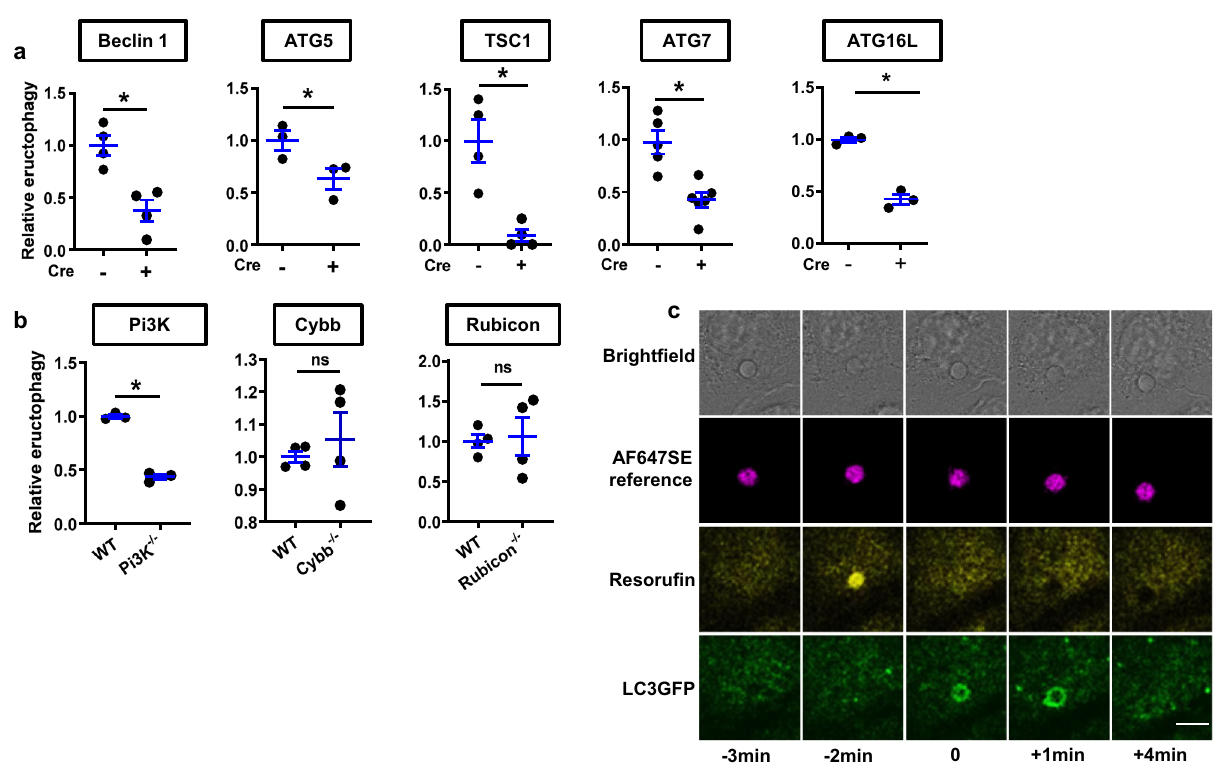
Fig. 5 Autophagic machinery is required for eructophagy. Eructophagy was detected by hydrolysis of the membrane impermeant substrate resoru fi n maltotriose (yellow) by α -amylase conjugated to 3.0 μ m reporter particles within phagolysosomes between 1 and 3 h following phagocytosis by BMMØs. Particles are labelled with the reference fl uor AF647SE (magenta). a Rates of eructophagy in BMMØs conditionally de fi cient in Beclin 1, ATG5, TSC1, ATG7 and ATG16L (Cre + ) relative to BMMØs derived from Cre-negative littermates (Cre − ). b Eructophagy is reduced in BMMØs de fi cient in Pi3K γ , but not in Cybb or Rubicon relative to BMMØs derived from C57BL6/J mice (wild type; WT). c Representative images before, during and after an eructophagy event (yellow) in BMMØs derived from mice expressing LC3-GFP (green). LC3-GFP recruitment to the phagolysosome was observed to be temporally associated with 88% (±3.1%) of all eructophagy events observed in these cells. Error bars presented as means± SEM. * P = (a) 0.0047, 0.0479, 0.0052, 0.0019 and 0.0004; (b) 0.0001, 0.5513 and 0.8169 by Student ’ s two-tailed unpaired t -test. Time 0 represents an eructophagy event. Scale bars denote 10 μ m. a , b n = 3, n = 4 or n = 5 mice per group, as shown by the number of data points on the graph. Source data are provided as a Source Data fi